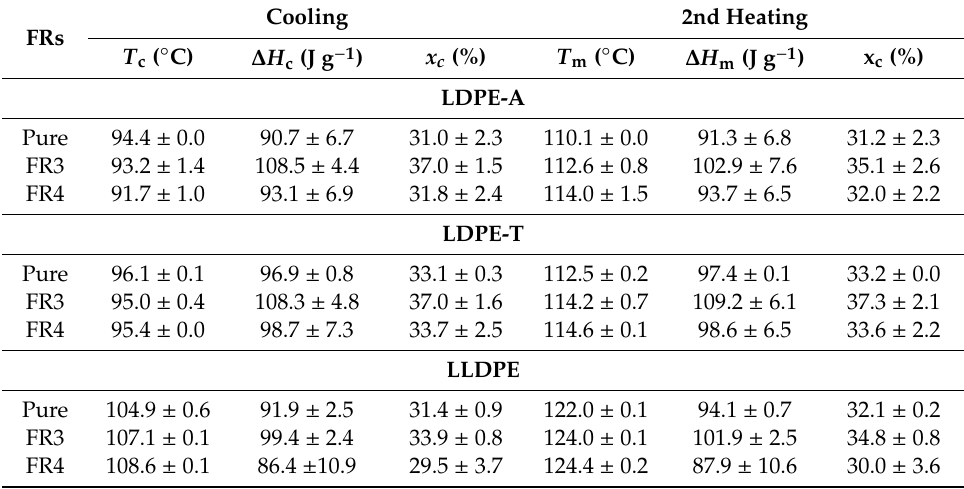
Table 3. Thermal properties of pure polyethylene grades and selective FR polyolefin formulations.